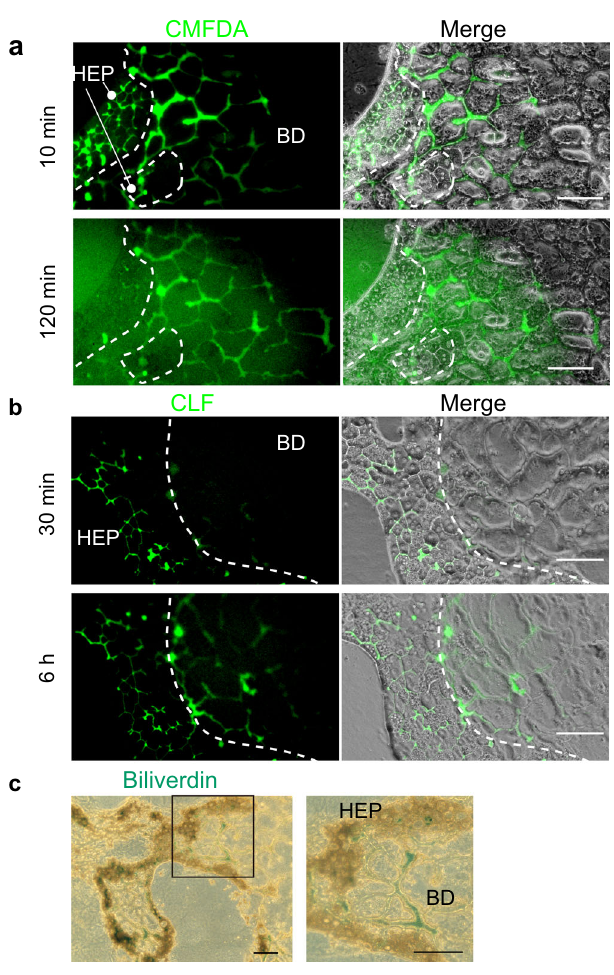
Fig. 3 Transport of hepatocyte metabolites in HBTO. a Transport of fl uorescein diacetate in HBTOs. Fluorescein derived from chloromethyl fl uorescein diacetate (CMFDA) is secreted into BCs and then transported into the biliary network. After 10 min of incubation, fl uorescein is strongly detected in the BC network of the hepatocyte cluster (HEP, surrounded by a broken line), as well as in the biliary network (BD). Fluorescein is absent from the hepatocyte clusters and reaches the biliary network after 120 min incubation. HBTOs were incubated in the presence of CMFDA for 10 min. Phase-contrast and fl uorescent images were taken after washing with culture medium fi ve times. HBTOs were kept in the culture medium without CMFDA. Dotted lines indicate the boundary between HEP and BD. The experiment on one well was repeated three times, independently. Two fi elds were examined in each well and the representative images are shown in this fi gure. Bars represent 100 μ m. b Transport of bile acids in HBTO. CLF taken up by hepatocytes is transported into the biliary network. The organoids were incubated in the presence of CLF for 30 min. After fi ve washes, images were taken at 30 min (panels 1 and 2) and at 6 hours (panels 3 and 4). Broken lines indicate the boundary between HEP and BD. The experiment using one well was repeated three times, independently. Three fi elds were examined in each well and the representative images are shown in this fi gure. Bars represent 100 μ m. c Transport of bilirubin. Bilirubin taken up by hepatocytes is excreted into BCs and then transported into the biliary network. Bilirubin in HBTOs was visualized by turning it into biliverdin. The experiment on one well was repeated three times, independently. Three fi elds were examined in each well and the representative images are shown in this fi gure. The box in the left panel is enlarged in the right panel. Bars represent 200 μ